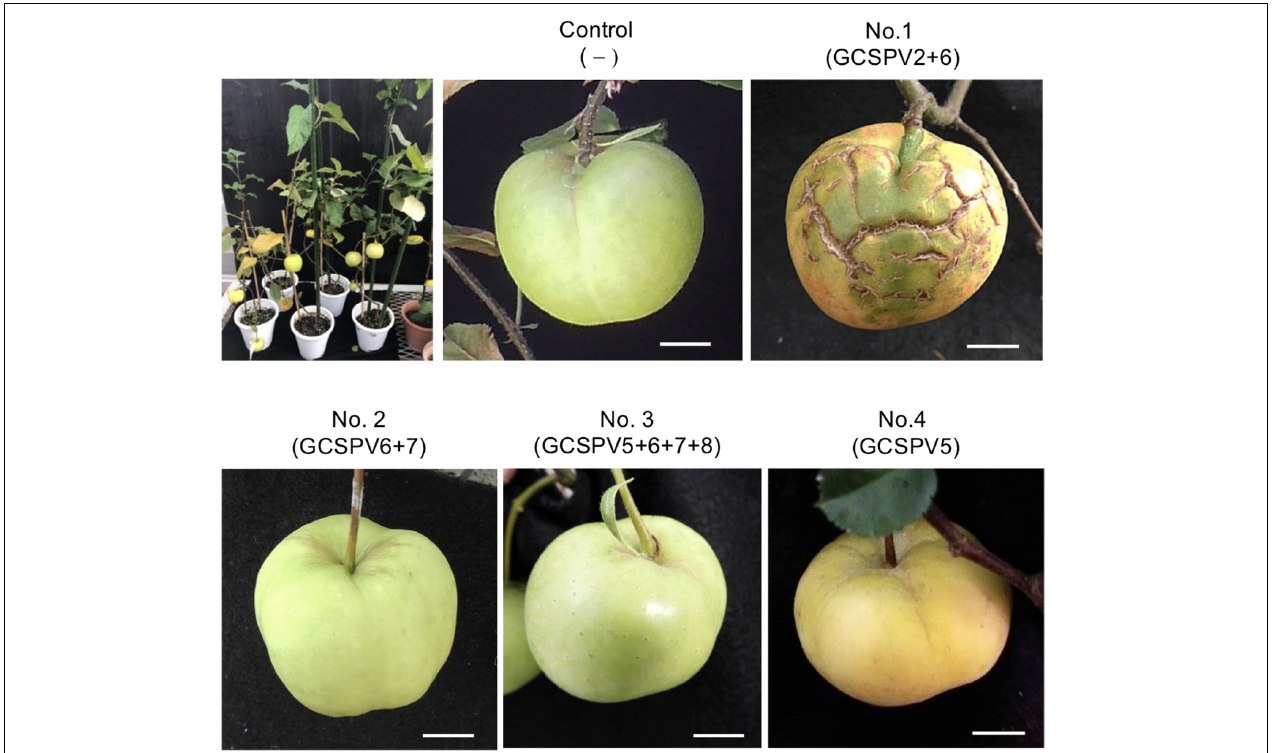
FIGURE 4 | Apple seedlings inoculated with RNA transcripts of ASPV and ALSV-AtFT/MdTFL1 about 10 months after inoculation (upper left) and fruits produced on the inoculated apple seedlings. Control; infected with ALSV-AtFT/MdTFL1 only, No. 1; with GCSPV2 and GCSPV6, No. 2; with GCSPV6 and GCSPV7, No. 3; with GCSPV5, GCSPV6, GCSPV7, and GCSPV8, No. 4 with